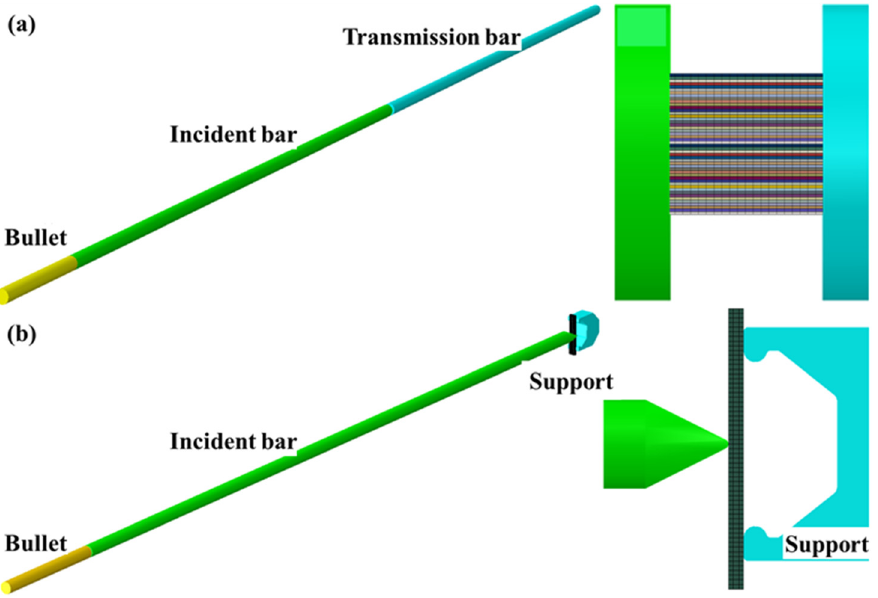
Figure 3. Finite element model. ( a ) Hopkinson pressure bar and dynamic compression sample. ( b ) Hopkinson bending bar and dynamic bending sample.